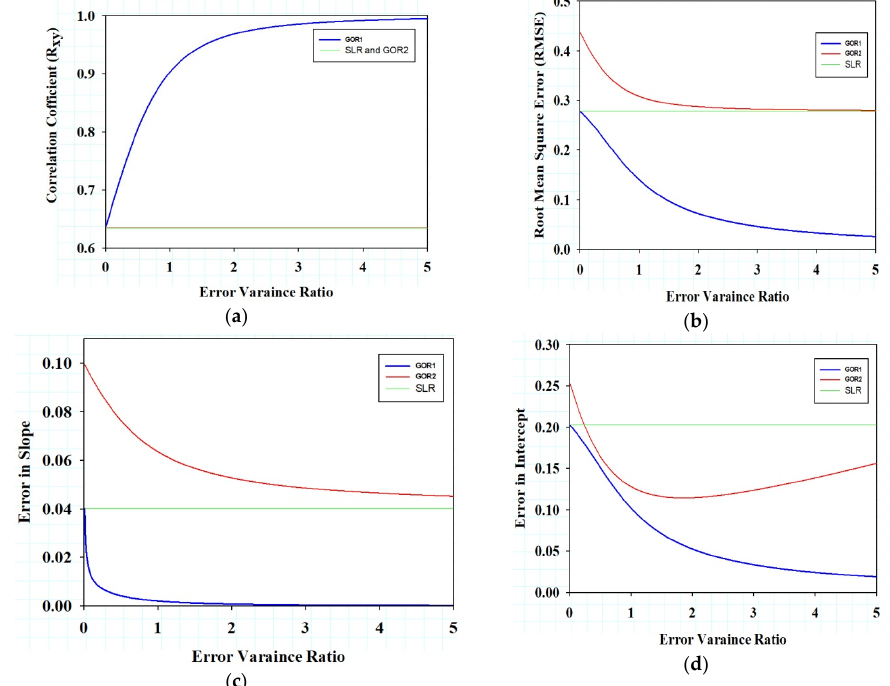
Figure 14. Comparison of the uncertainty in regression parameters for (M D – M wg ) data pairs using GOR1, GOR2, and SLR approaches considering function of error variance ratio: ( a ) Correlation Coefficient determination (R xy ), ( b ) Root mean square error (RMSE), ( c ) uncertainty values of slope and ( d ) uncertainty of